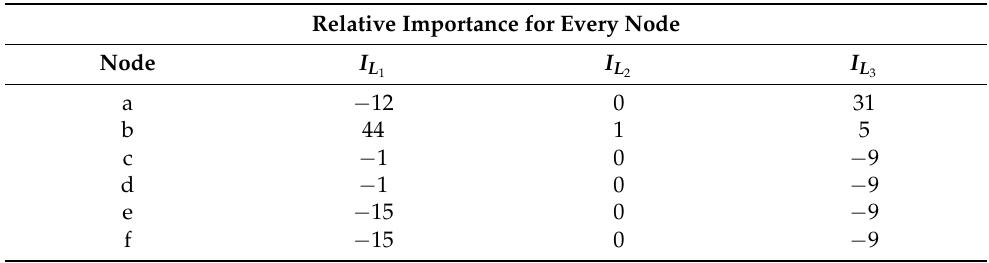
Table 1. Relative importance of every node in layer L 1 from MLN4 in in Figure 1.